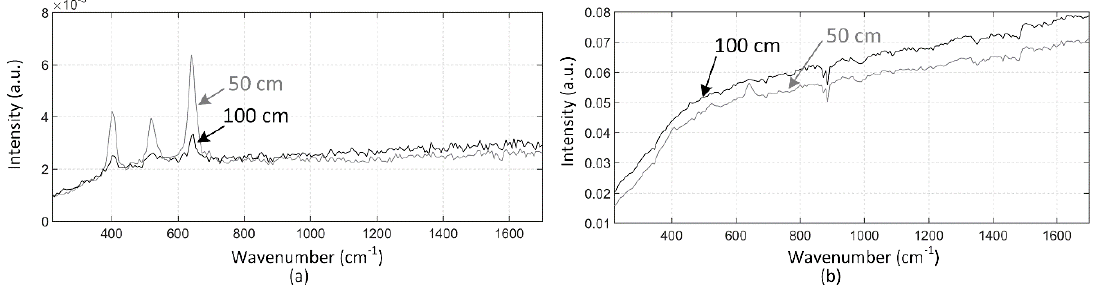
Figure 8. Raman spectra of TiO 2 measured ( a ) by gating the bins of the TDC to collect photons from targets at 50 cm and 100cm, and ( b ) by collecting photons within the collection window at 10 ns with a halogen lamp shining behind the target.